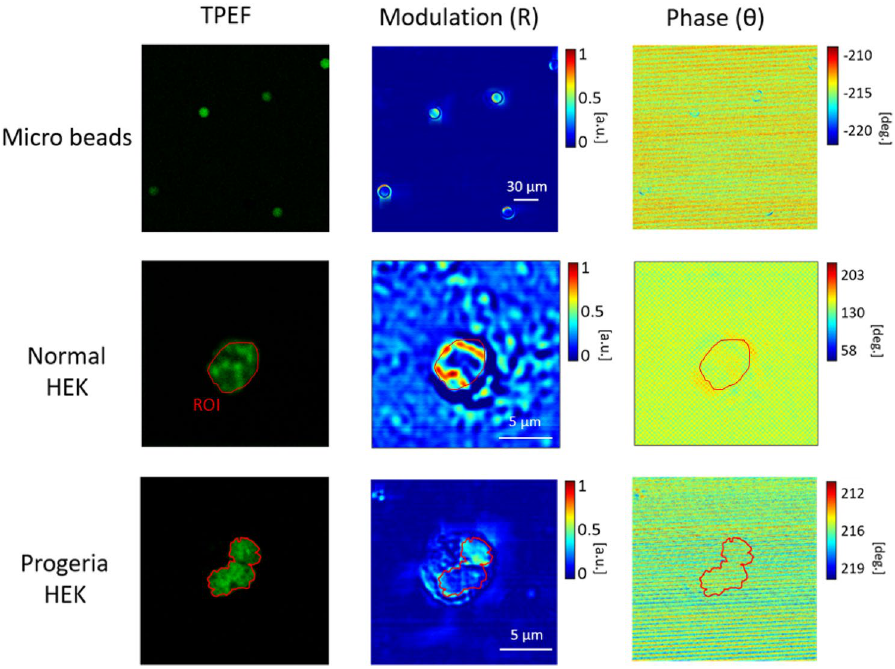
Figure 5. Fluorescent images of microbeads as reference, the isolated normal HEK nucleus and progeria HEK syndrome compared to corresponding polarimetric modulation and phase images.